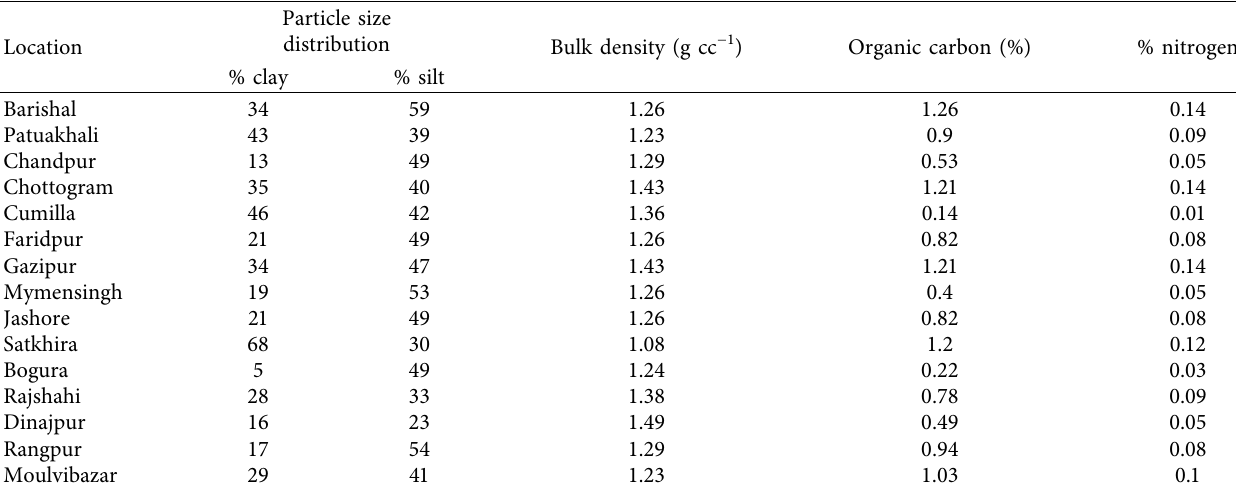
Table 2: Physical and chemical properties of soil in the study locations.